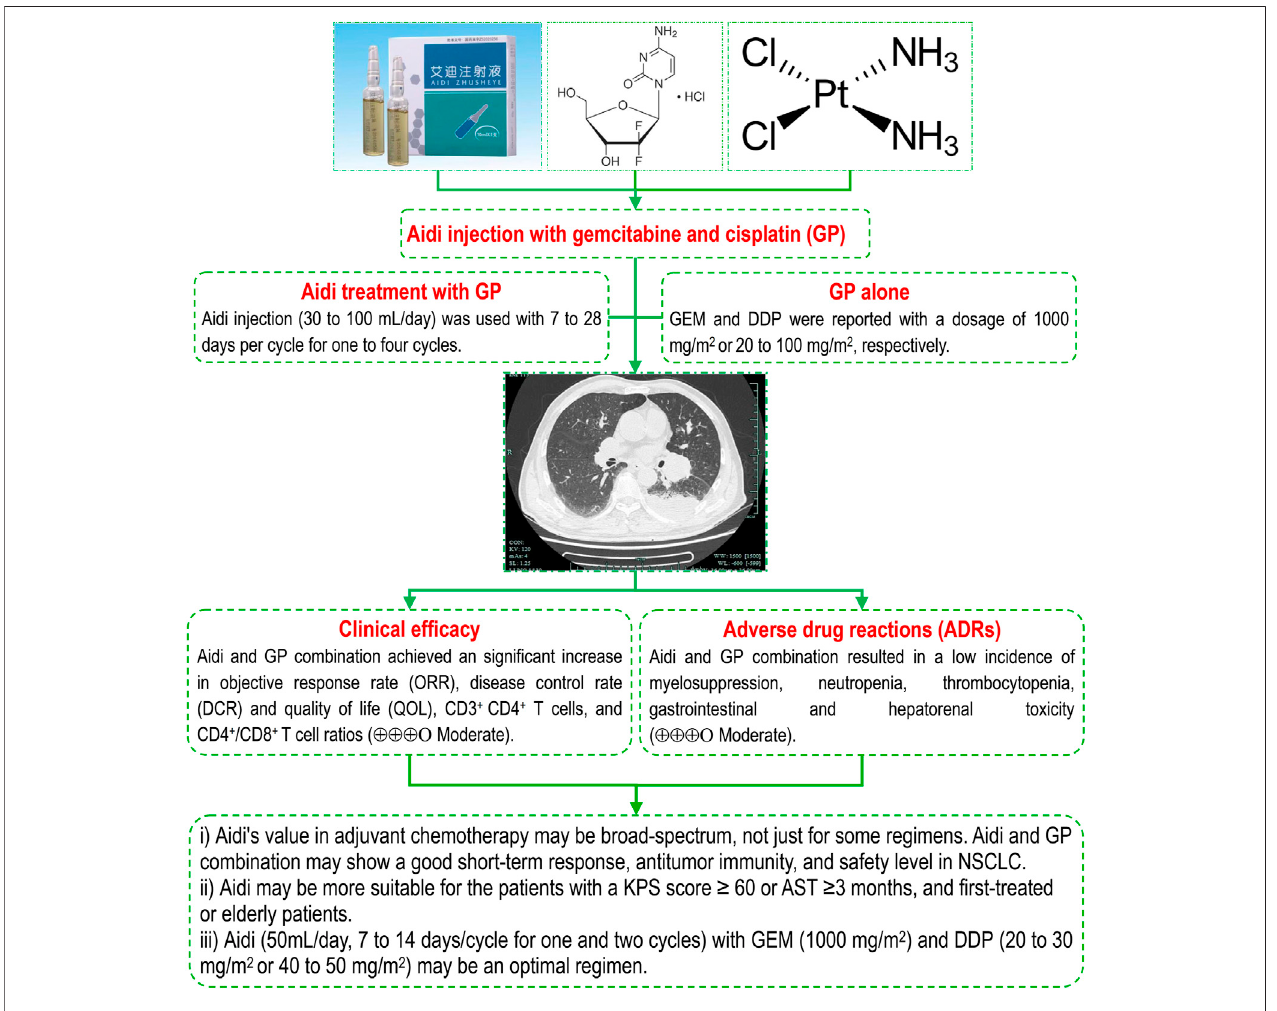
FIGURE8| Aidiinjection and GPcombinationinNSCLC,Aidi ’ svalueinadjuvantchemotherapymaybebroad-spectrum,notjustforsomeregimens. TheAidiand GPcombination may show a good short-term response, antitumor immunity, and safety level in NSCLC. Aidi may be more suitable for patients with a KPS score ≥ 60 or AST ≥ 3 months, and fi rst-treated or elderly patients. Aidi (50 ml/day, 7 – 14 days/cycle for one and two cycles) with GEM (1000 mg/m 2 ) and DDP (20 – 30 mg/m 2 or 40 – 50 mg/m 2 ) may be an optimal regimen. Note: AST, anticipated survival time; DCR, disease control rate; DDP, cisplatin; GEM, Gemcitabine; KPS: KPS, Karnofsky Performance Status; NSCLC, non-small cell lung cancer; ORR, objective response rate.